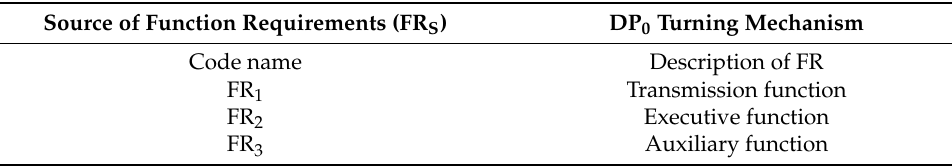
Table 4. List of terminal nodes for FR 1 , FR 2 , and FR 3.